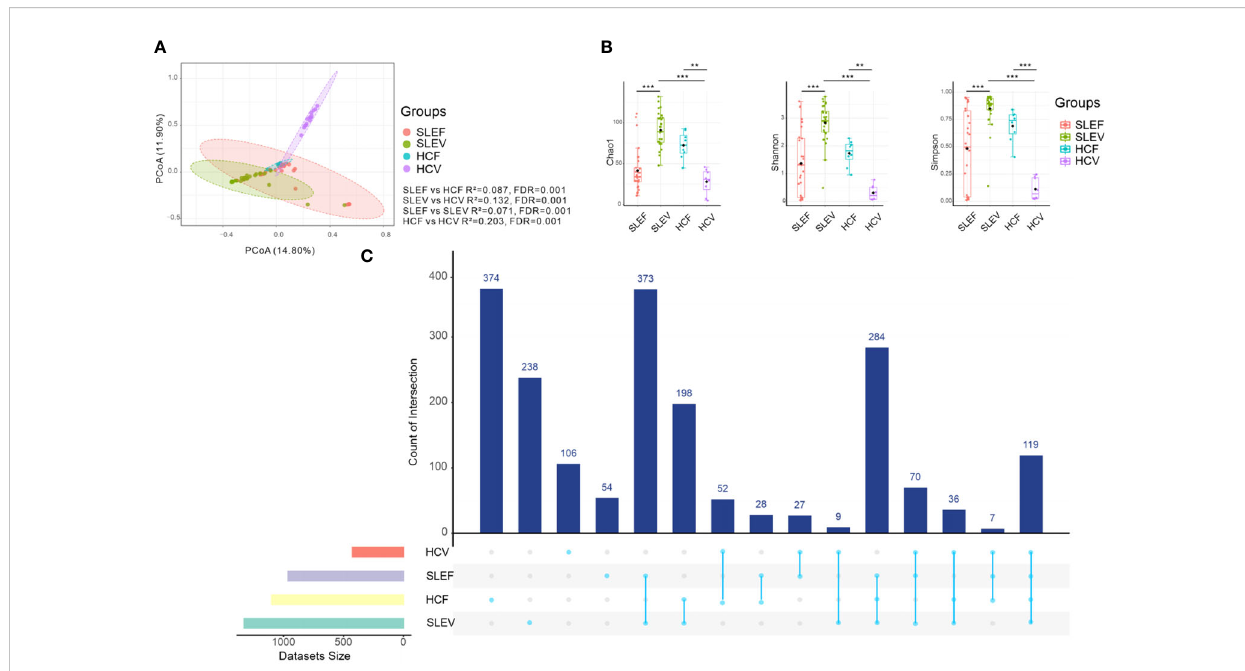
FIGURE 1 Bacterial composition, bacterial diversity, and UpSet in the feces and vaginas of SLE patients and HC. (A) PCoA based on Bray − Curtis distances ASV level. The 95% con fi dence ellipse is drawn for each group. Permutational multivariate analysis of variance (PERMANOVA) was performed for statistical comparisons of samples in the two groups. The P value was adjusted by the Benjamini and Hochberg false discovery rate (FDR). (B) Bacterial richness and diversity measured using the Chao 1, Shannon, and Simpson indexes were calculated at the ASV level. The Wilcoxon rank- sum test was performed and adjusted by Benjamini and Hochberg ’ s false discovery rate (FDR). ** P adj < 0.01, *** P adj < 0.001. (C) UpSet plots illustrating the quantitative intersection of the sets of ASVs across the samples. The numbers above the bars show the number of common ASVs between the groups of the samples of SLEF, SLEV, HCF, and HCV. HCF, HC feces; HCV, HC vagina; SLEF, systemic lupus erythematosus feces; SLEV, systemic lupus erythematosus